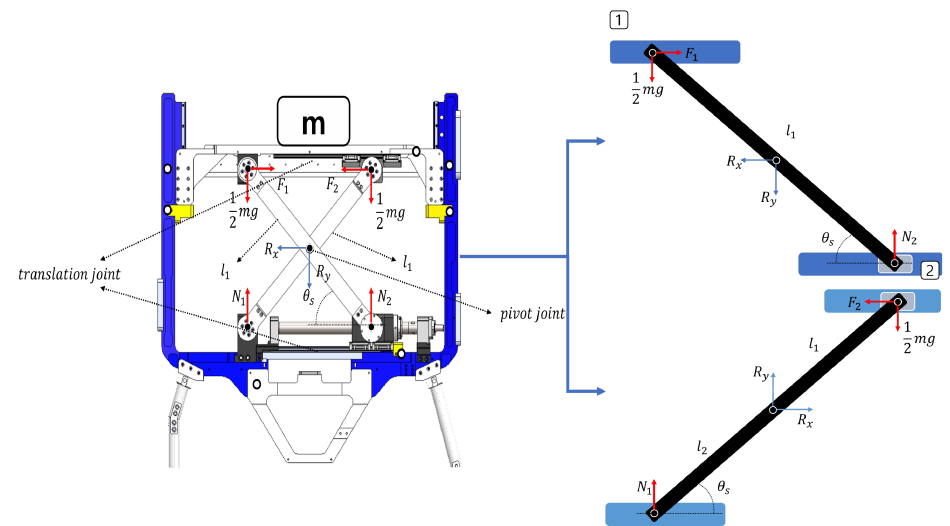
Figure 5. Relationship of forces generated by scissor mechanism when a certain mass is present. l 1 is the scissor mechanism link length and θ s is the scissor mechanism angle. Number 1 box and 2 box show the scissor mechanism link separately and derive free body diagram for showing force